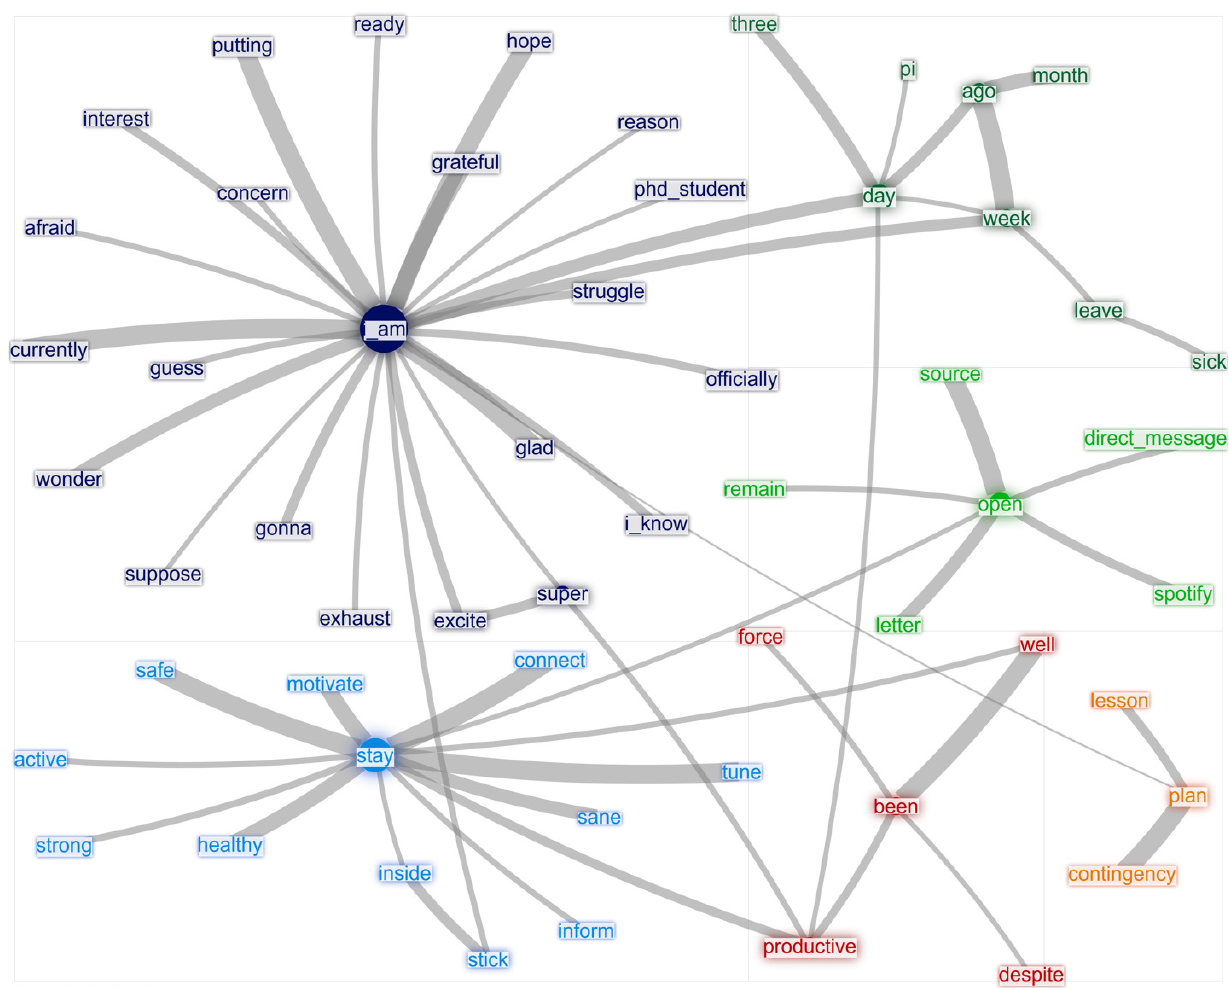
Figure 3. Discussions around social support within